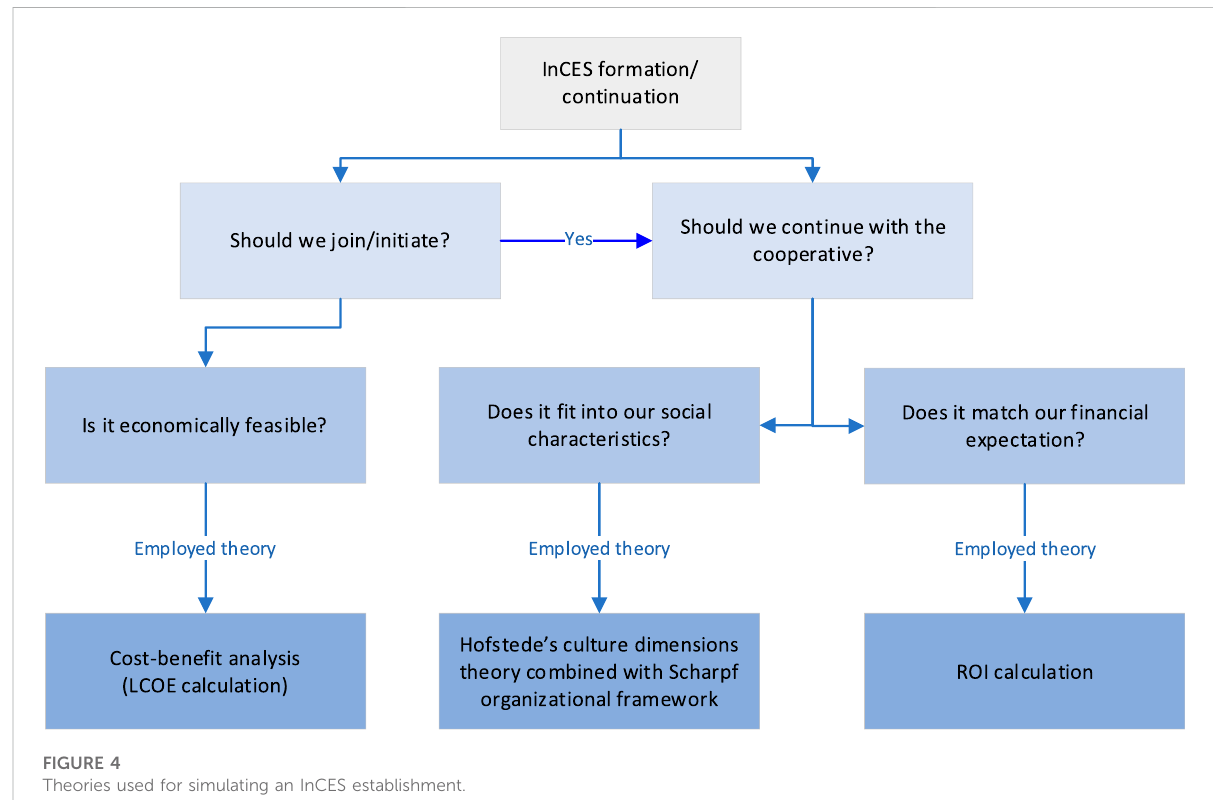
FIGURE 4 Theories used for simulating an InCES